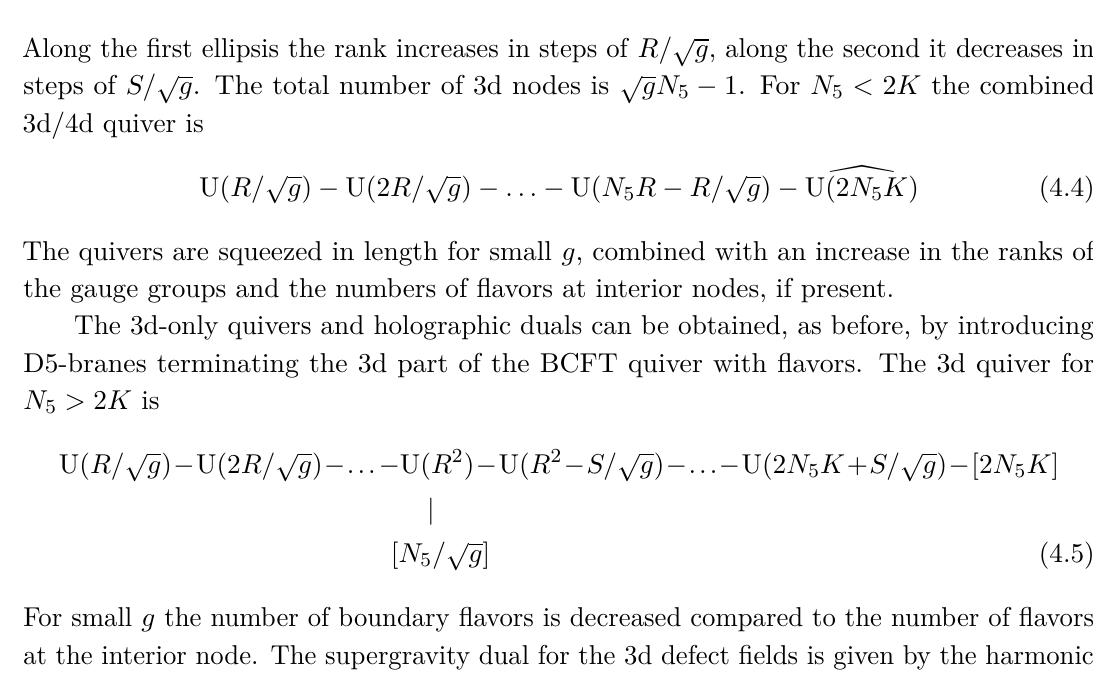
√ g , along the second it decreases in √ gN − 1 . For N < 2 K the combined 5 5